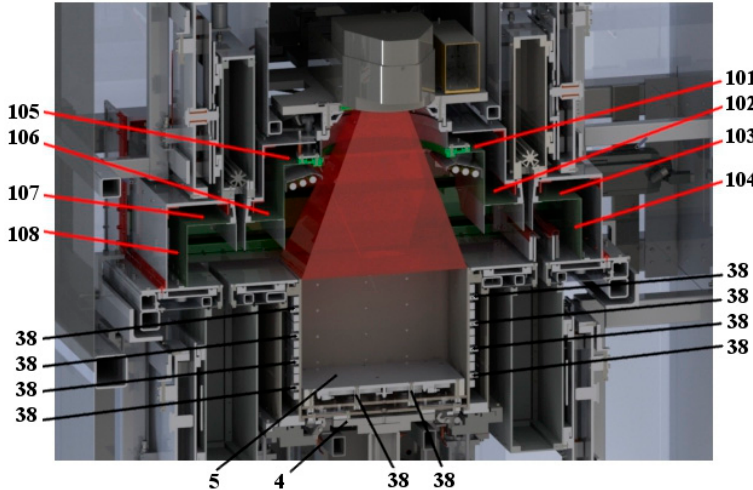
Figure 8. Details of the “Zone A” area from Figure 3a: points (101–108) are the locations of specially installed thermocouples for the experiment, points 38 are stationary thermocouples of the installation (repeat position with Figure 3a), 4—lower transition table, 5—building platform (repeat position with Figure 3a).